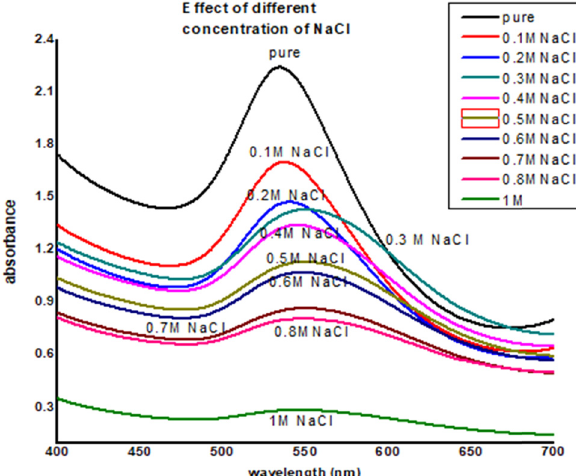
Figure 7: AuNPs of sa ff ron stigma ( SS - AuNPs ) at di ff erent pH values.